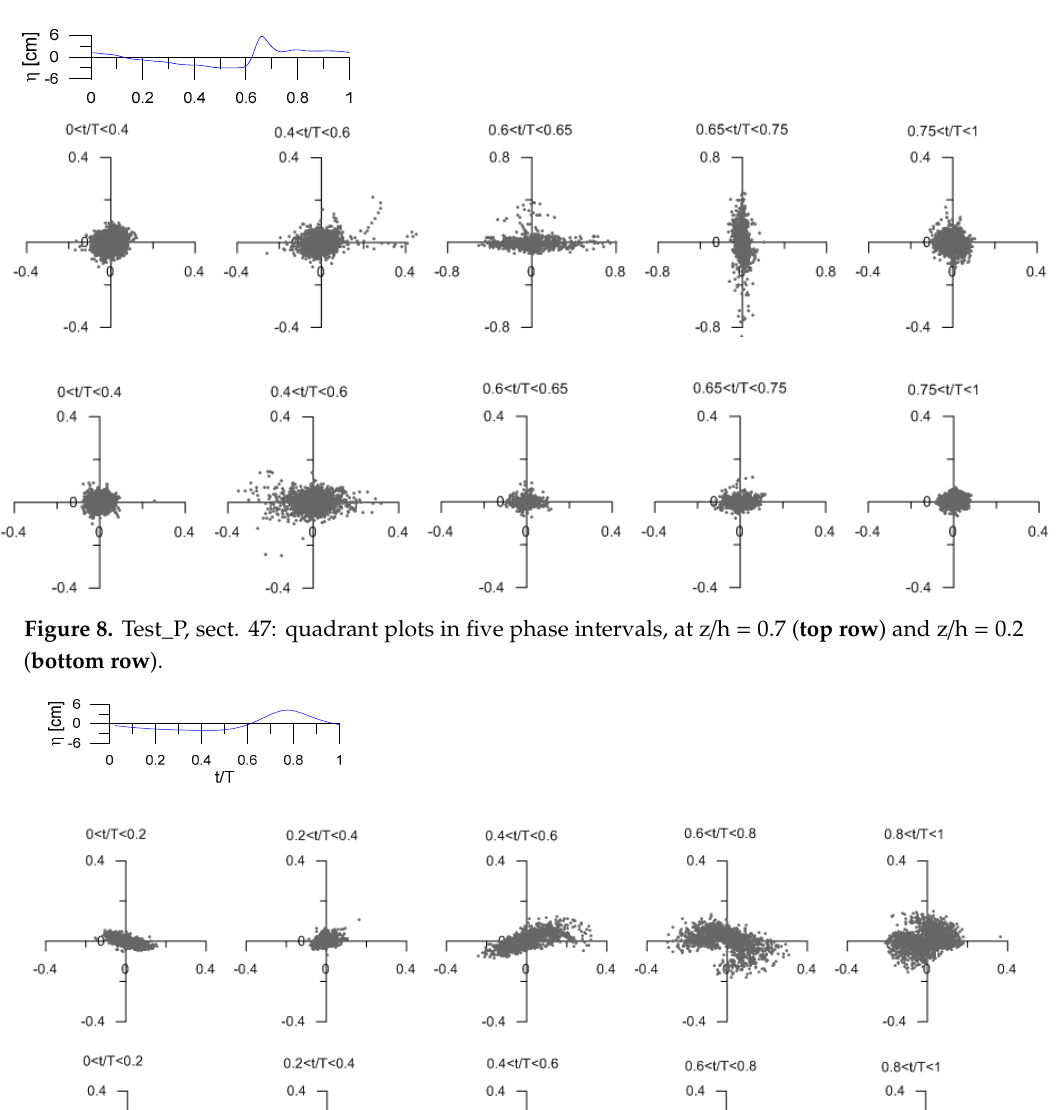
Table 2. Coherent and intense coherent events detected for TEST_P and TEST_S by means of the threshold values for the signal u’w’ .